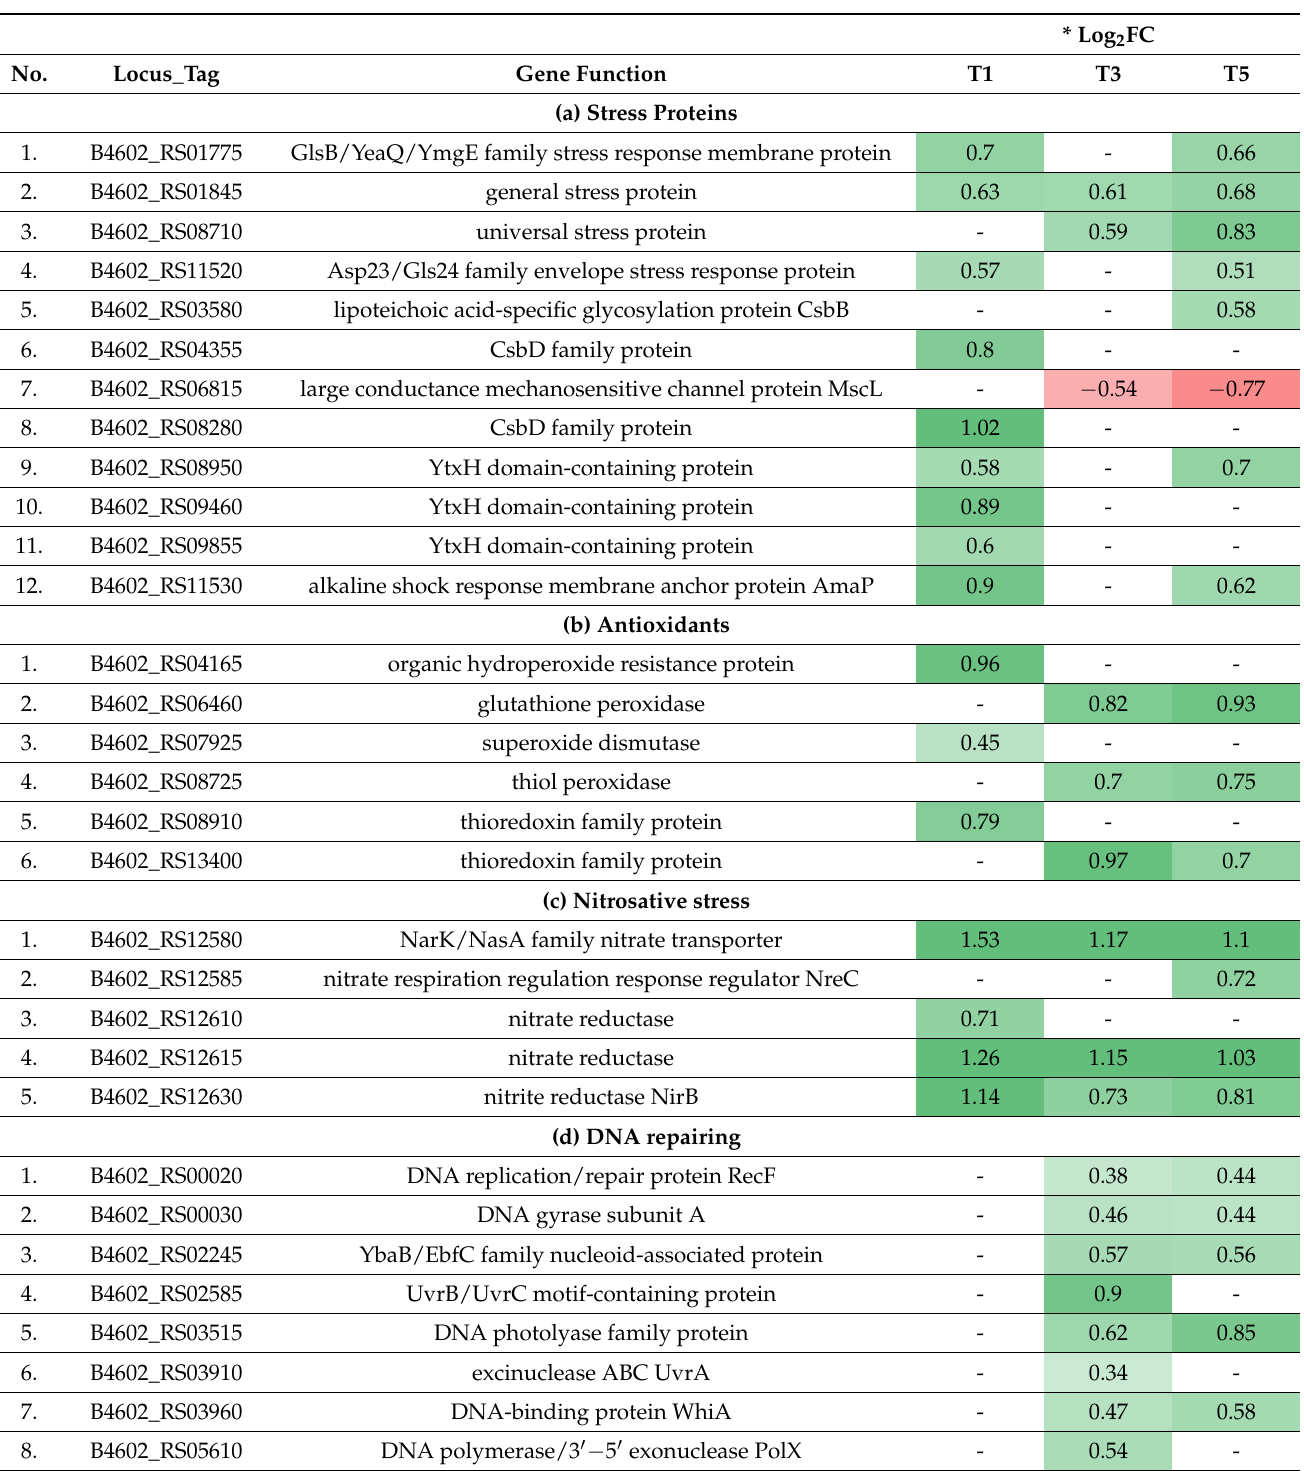
Table 2. List of DEGs related to various biological processes identified in T1, T3, and T5 treatments. The biological processes include (a) stress proteins, (b) antioxidants, (c) nitrosative stress, and (d) DNA